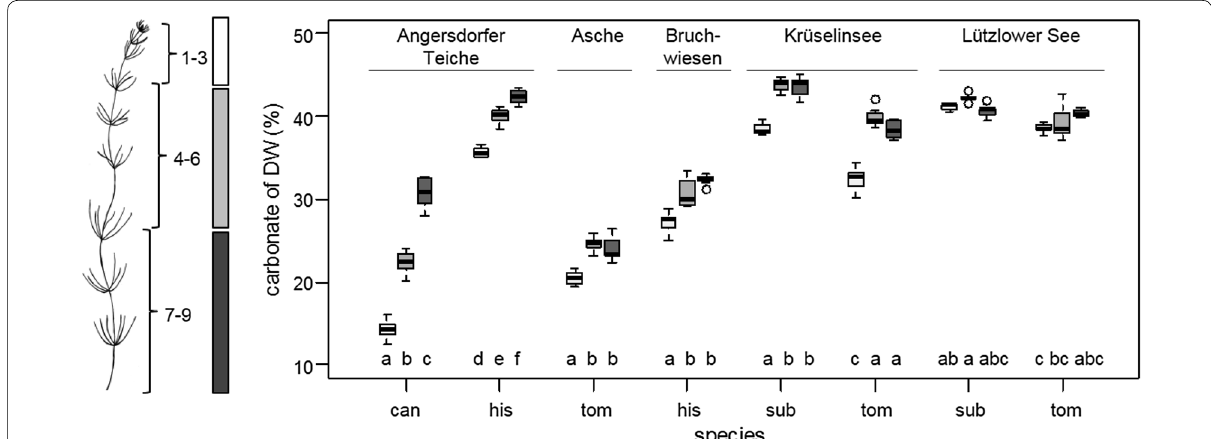
Fig. 2 Comparison of carbonate content based on DW (%) of C. canescens (can), C. hispida (his), C. subspinosa (sub), and C. tomentosa (tom) from sampling sites (Angersdorfer Teiche, Asche, Bruchwiesen, Krüselinsee, and Lützlower See). Plants were analyzed in first to third (white), forth to sixth (light grey), seventh to ninth (dark grey boxplots) whorls and internodes. Box plots include whiskers (5–95% of variability) and outliers (points).